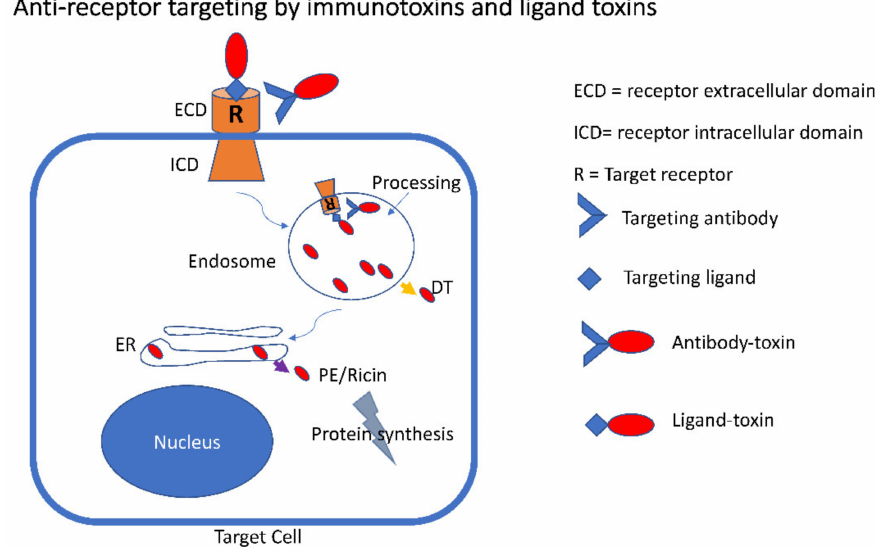
Figure 2. Anti-receptor targeting by immunotoxins and ligand toxins. A ligand toxin is shown interacting with a target receptor at the ligand-binding site. Similarly, an immunotoxin is shown binding the same receptor but at a distinct site. Following binding, internalization results in delivery